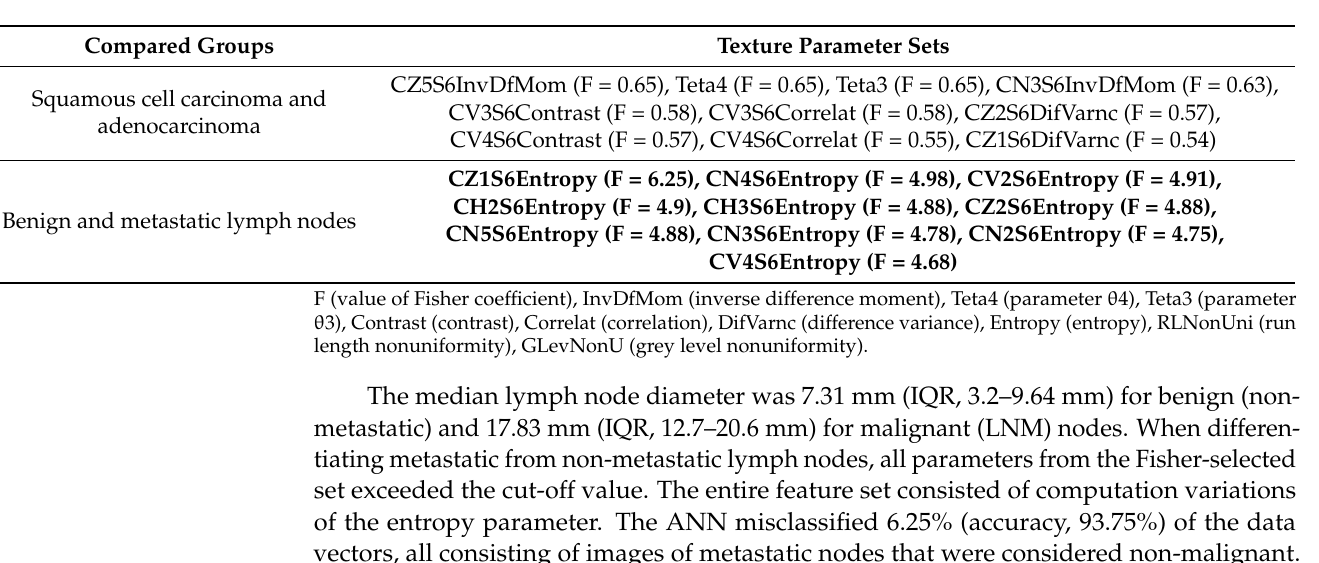
Table 1. Texture parameters selected by the Fisher method as having the highest discriminatory potential between compared groups. Parameters with adequate discriminatory potential (F > 3) are marked in bold.